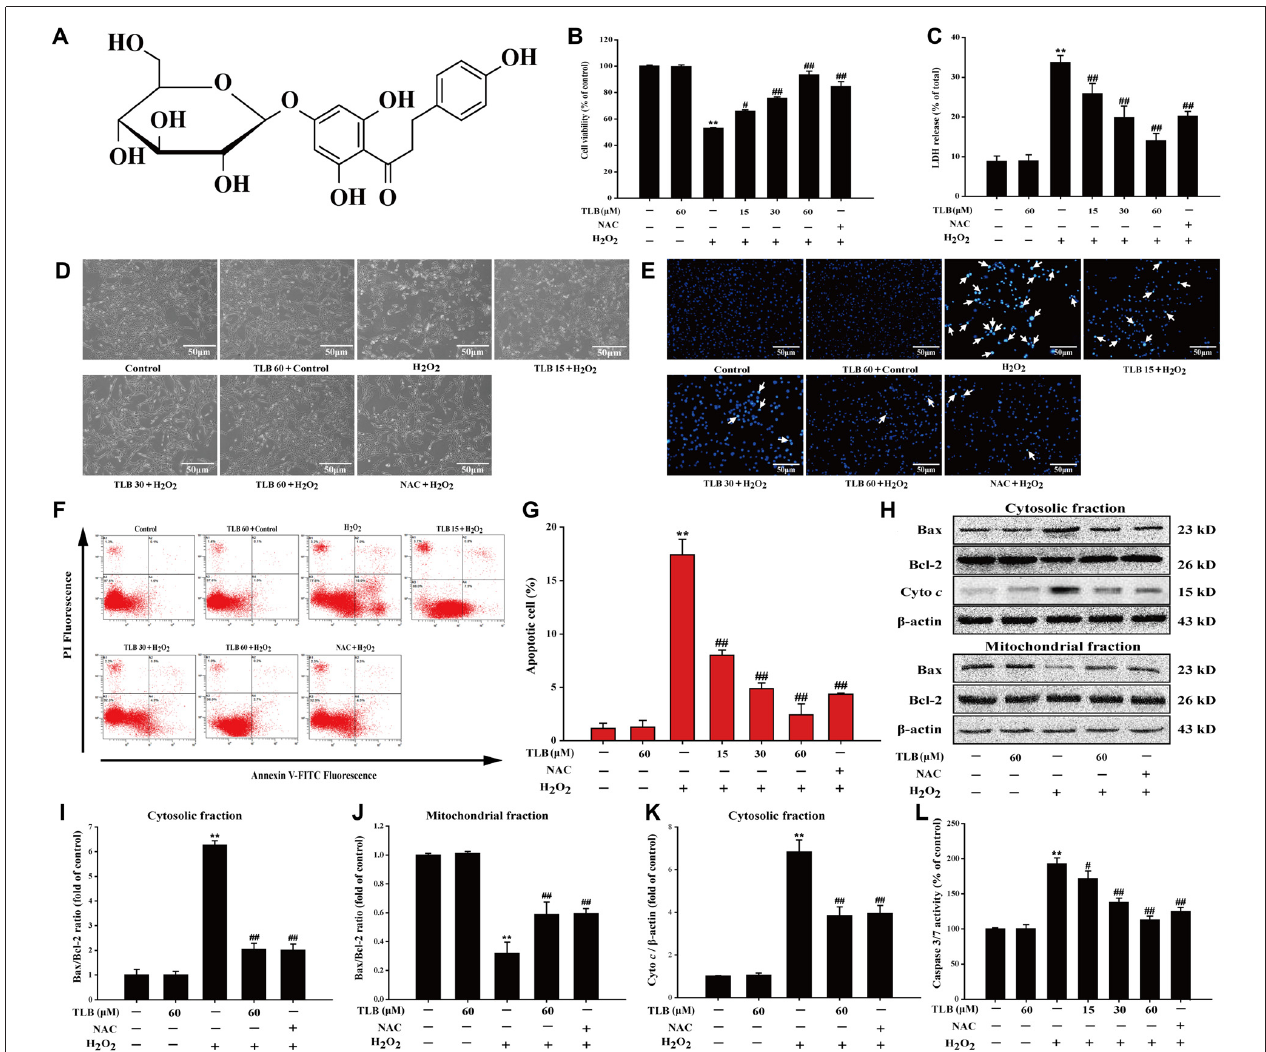
FIGURE 1 | Trilobatin (TLB) protected PC12 cells against hydrogen peroxide (H 2 O 2 )-induced oxidative injury and cell demise. (A) The chemical structure of TLB. After pre-treatment with different concentrations of TLB, cells were treated with 400 µ M H 2 O 2 for another 48 h. (B) Cell viability was determined using 3-(4,5-dimethythiazol-2-yl)-2,5-diphenyltetrazolium bromide (MTT) assay. (C) Lactate dehydrogenase (LDH) release was determined using an LDH release assay. (D) The protective effect of TLB on H 2 O 2 -induced morphological changes in PC12 cells. Magnification, 200 × ; scale bar = 50 µ m. (E) PC12 cells were stained by Hoechst 33342 dying, and apoptotic cells were labeled with white arrows indicating a nuclear shrinkage or intensive fluorescence. Magnification, 200 × ; scale bar = 50 µ m. (F) Early apoptotic cells were detected by flow cytometry of annexin/propidium iodide (PI) double stained. (G) Bar graphs showed the quantification of early apoptotic cells. (H) Representative Western blot were shown for the expressions of Bax and Bcl-2 both in the cytoplasmic and mitochondrial fraction. (I) Quantitation of the ratio of Bax/Bcl-2 in the cytoplasmic fraction. (J) Quantitation of the ratio of Bax/Bcl-2 in the mitochondrial fraction. (K) Representative Western blot were shown for the expressions of Cyto c . (L) Quantification of caspase 3/7 activity was detected using caspase 3/7 activity assay. Data were presented as mean ± standard deviation (SD) of three independent experiments. ∗∗ P < 0.01 vs. untreated control cells; # P < 0.05, ## P < 0.01 vs. H 2 O 2 -treated